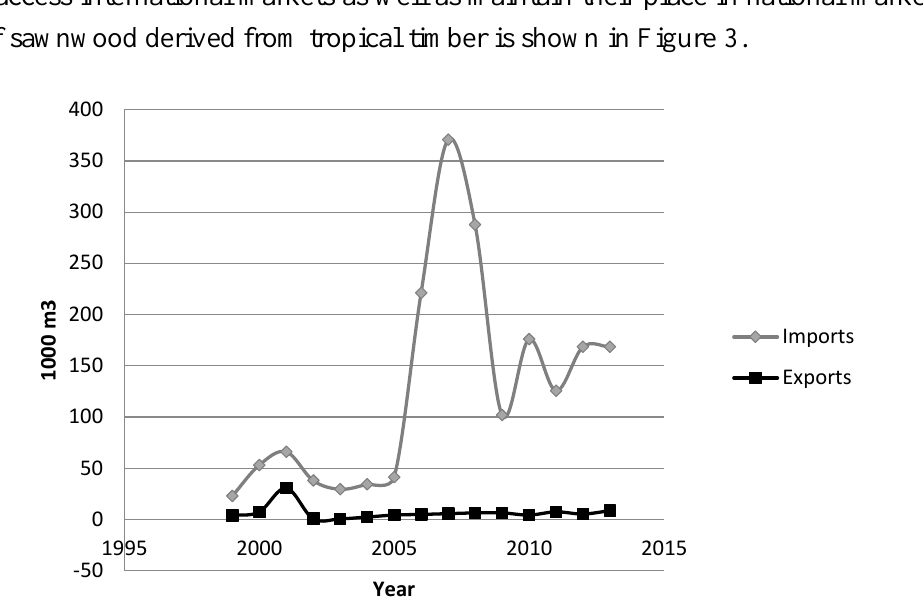
Figure 3. Mexican annual imports and exports of sawnwood from non-coniferous tropical species